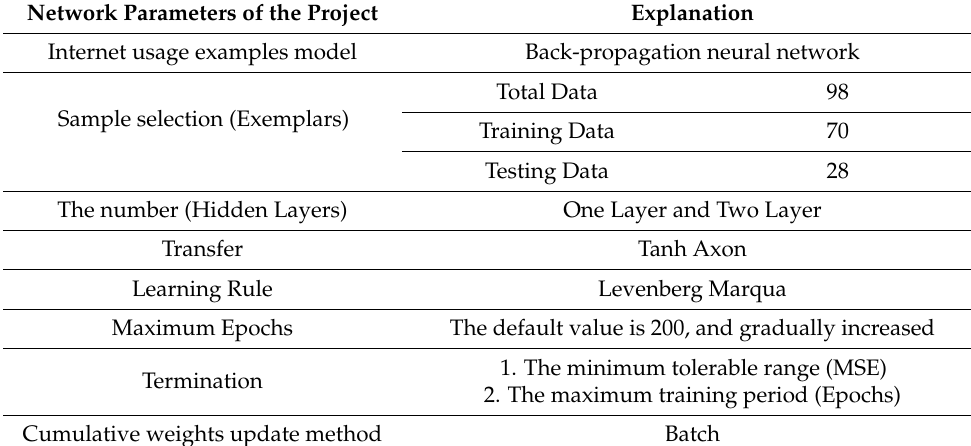
Table 2. Network model parameter settings.